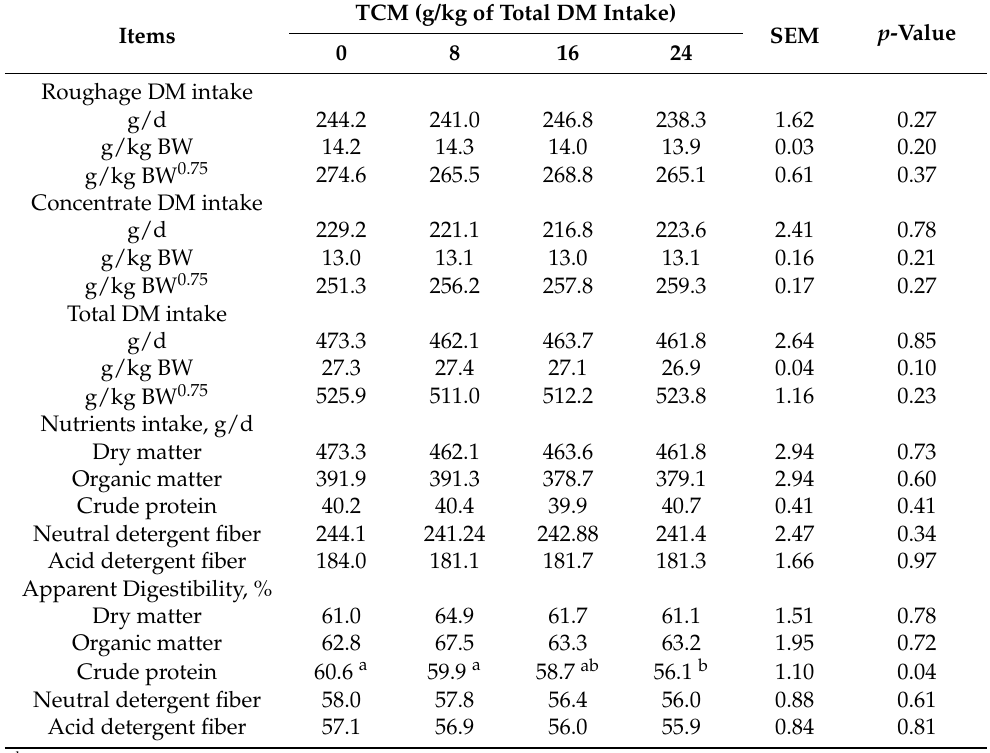
Table 2. Effect of Terminalia chebula meal (TCM) supplementation on feed intake and digestibility.